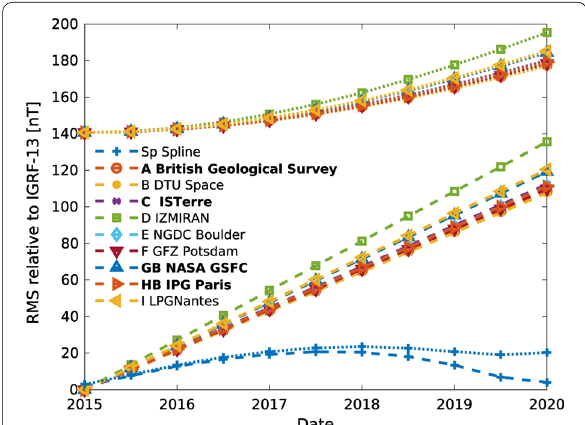
Fig. 8 Spectral RMS misfit between IGRF-13 and the 9 IGRF-12 SV candidate models for 2015.0–2020.0. Dashed lines represent coefficient differences to SH degree 8, dotted lines to SH degree 13 (with SV candidates zero-padded). “Spline” refers to an updated version of the BGS parent model built with data through February 2020. Those models labelled with bold text used physics based predictions, the remaining used mathematical